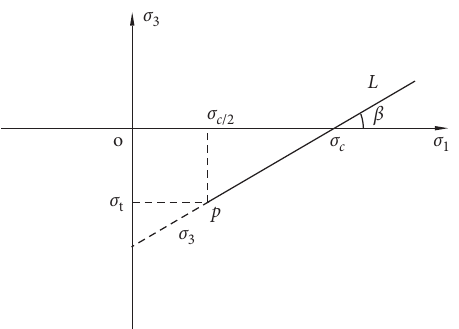
Figure 14: The coulomb criterion in the σ